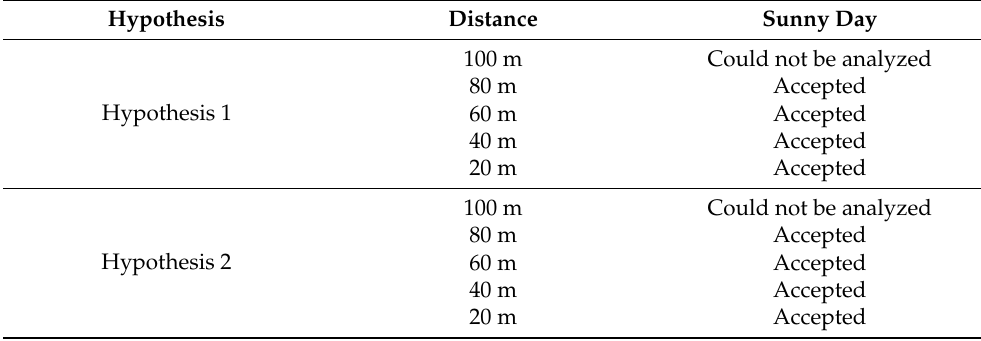
Table 4. Result of the ANOVA test on whether the material of the target and the speed affect the NPC for each distance.